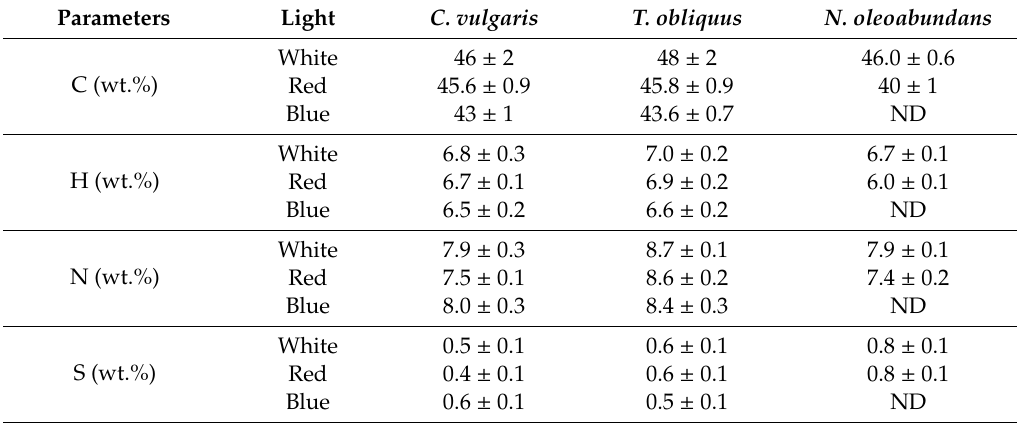
Table 3. Elemental analysis of the algal biomass grown under di ff erent light wavelengths. Parameters Light C.